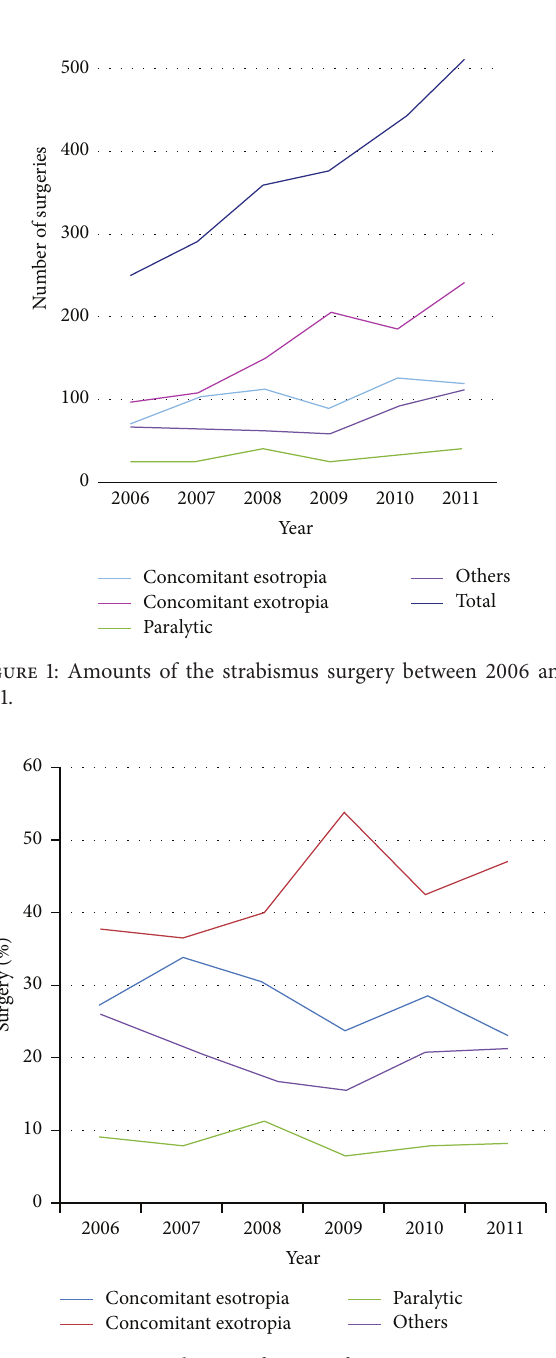
Figure 2: Distribution of surgery from 2006 to 2011.